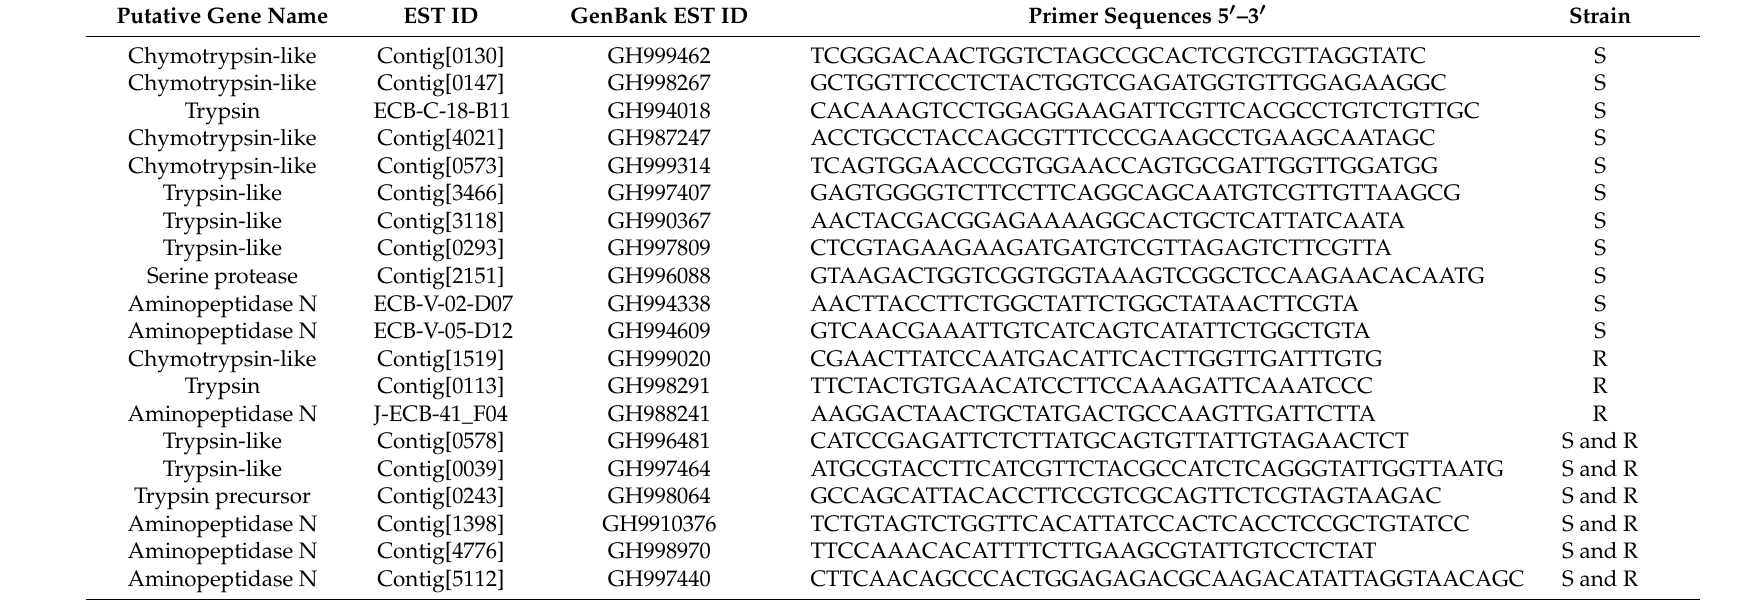
Table 3. Sequences of primers used in RT-qPCR